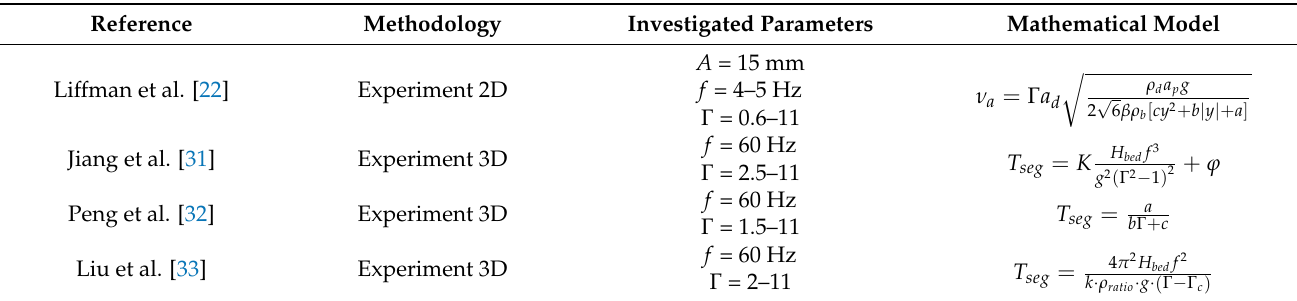
Table 1. List of models for the ascending of a spherical intruder in a vibrated bed of small particles.